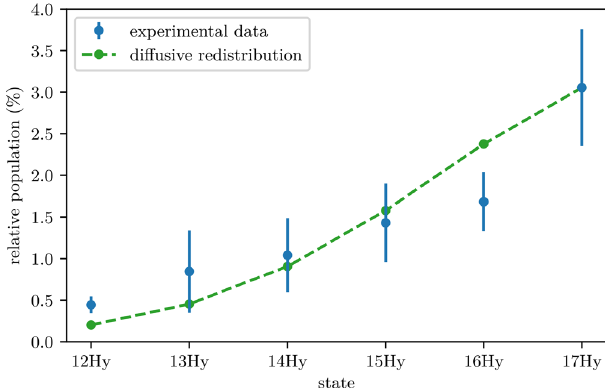
Fig. 7 Distribution of the fi nal state population upon state-changing collisions starting from 20P-ULRMs. The data are normalized to the sum of events that ended up in the respective states. The diffusive model (see text) is shown as green dashed line and reproduces the experimental data well. The error bars indicate systematic uncertainties of the determined